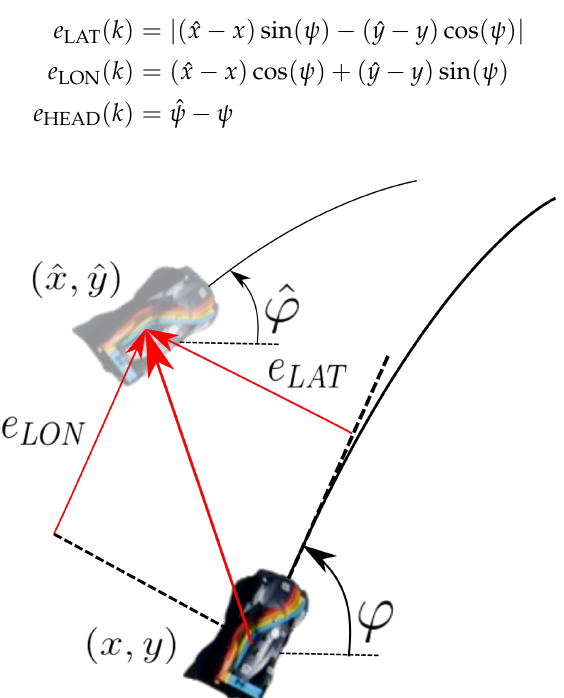
Figure 9. Longitudinal and lateral errors. These are computed as the distance error components along the GNSS defined car orientation